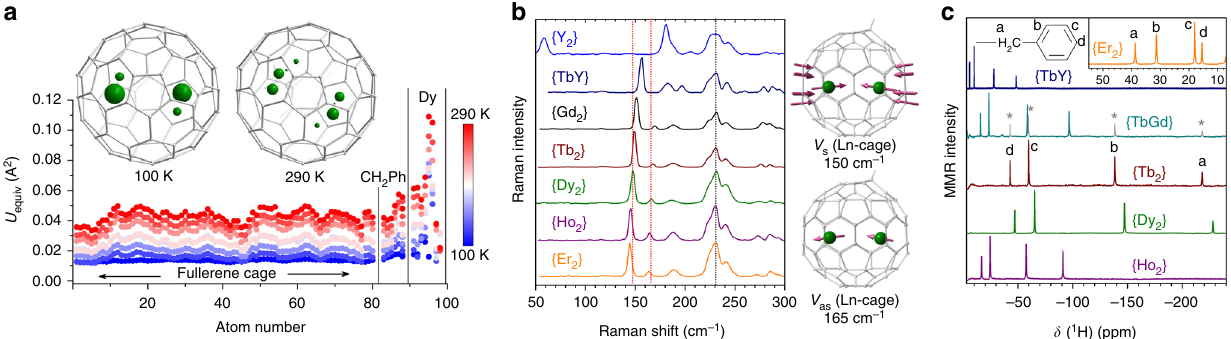
Fig. 2 Structure and dynamics of Ln 2 @C 80 (CH 2 Ph). a Molecular structure of {Dy 2 } at 100 and 290 K and atomic displacement parameters as a function of temperature between 100 and 290 K (to guide the eye, vertical lines separate displacement parameters of the C 80 cage, CH 2 Ph group, and Dy atoms); Dy atoms are shown as spheres with radii proportional to the site occupancies; b Raman spectra of {Ln 2 } compounds in the low-frequency range measured at 77 K; two metal-cage stretching modes are indicated by red dotted lines, the most prominent fullerene cage squashing mode is indicated by a black dotted line, atomic displacements for the metal-cage stretching modes near 150 and 165 cm − 1 are also shown on the right; c 1 H NMR spectra of {Ln 2 } measured in CS 2 solution at room temperature; {Tb 2 } signals in the spectrum of the {TbGd} sample are denoted